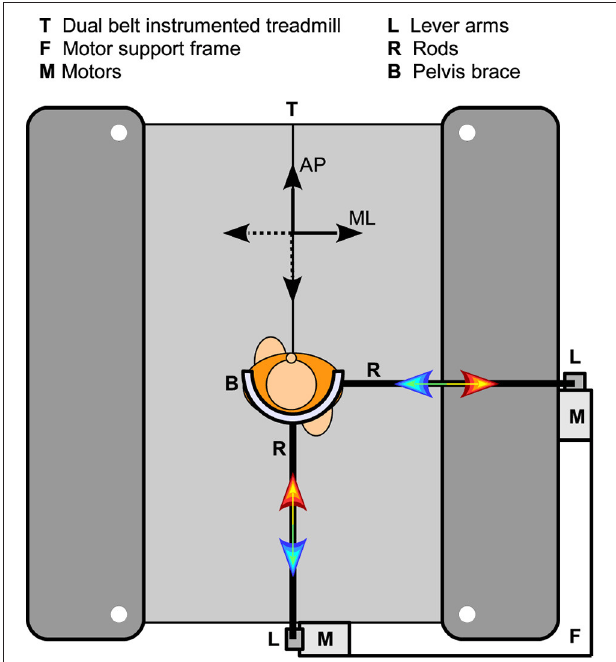
FIGURE 1 | Experimental setup. Two motors were fixated on a support frame, which in turn was attached to a dual-belt instrumented treadmill. Each motor could be connected to the subject through a vertical lever arm, a horizontal rod, and a hip brace. The two motors were never attached to the subject at the same